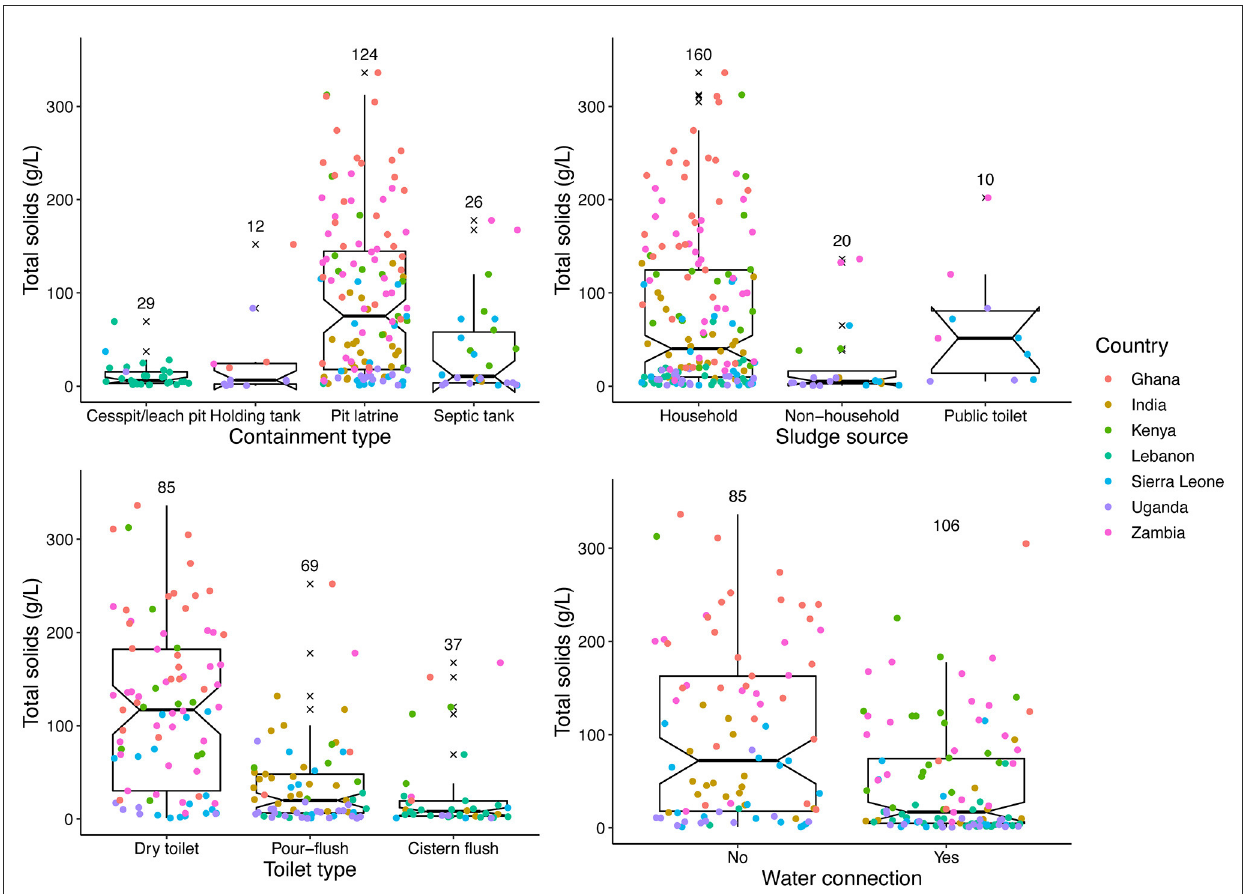
FIGURE5 Boxplots with TS by categories of containment type, sludge source, toilet type, and water connection. The number above each boxplot represents the number of samples in that category ( n ), notches in boxplots show confidence interval around the median, outliers are marked with a × .